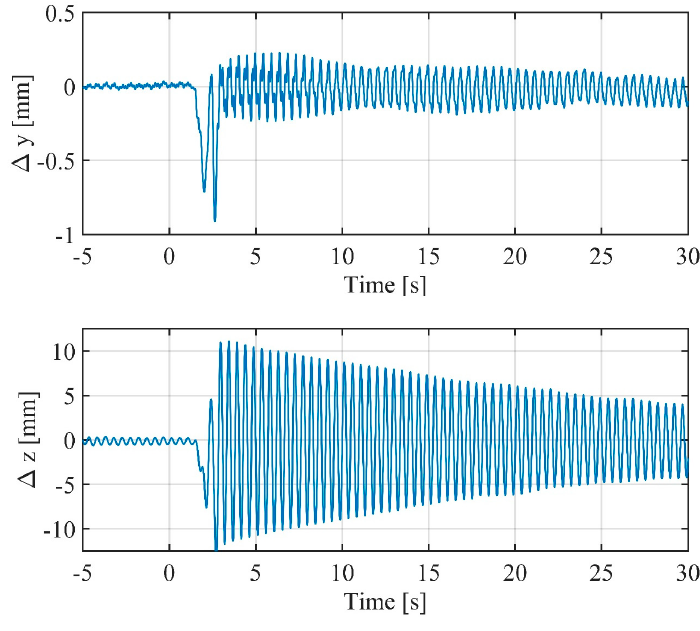
Figure 10. Displacement components retrieved using Equation (1).